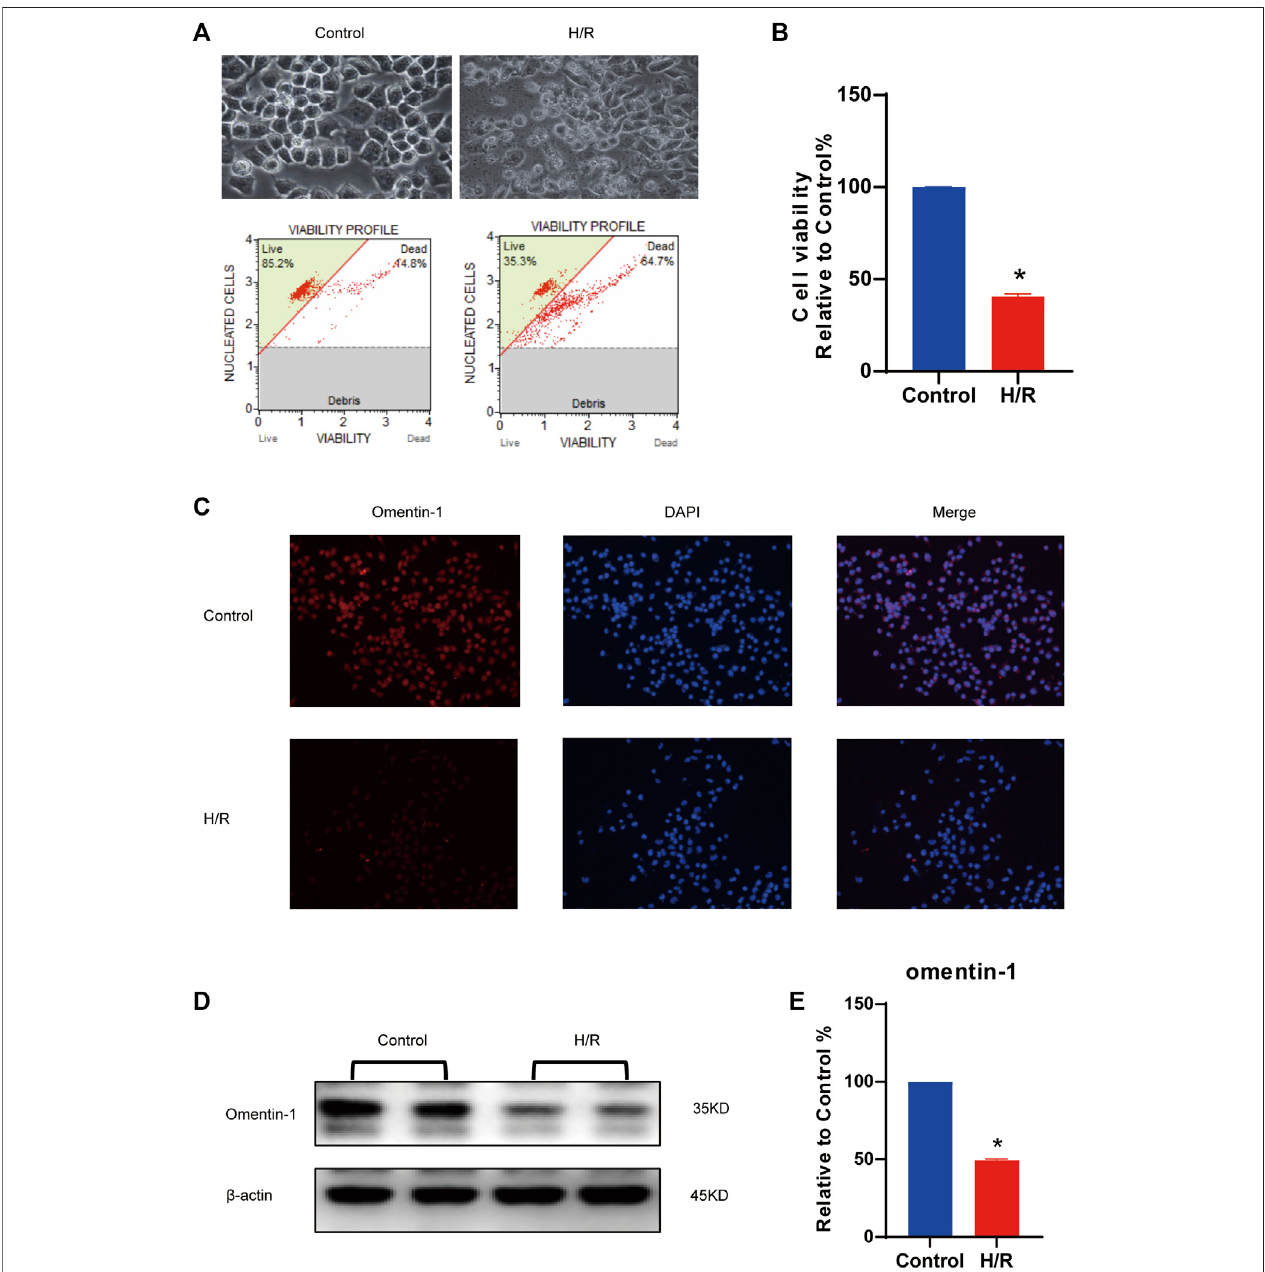
FIGURE 1 | Expression of omentin-1 in N2a cells injured by H/R. (A) H/R model was constructed in N2a cells. (B) Statistical graph of cell viability. (C) Omentin-1 expression inN2acellsinjuredbyH/Rdetectedbyimmuno fl uorescence. (D) Therepresentativeimagesofomentin-1detectedbyWesternblot. (E) Quantitativeanalysis of Western blot by normalizing to β -actin. Error bars show the standard deviation for n (cid:2) 6 measurements from representative experiments. * p < 0.05 vs. the Control group.